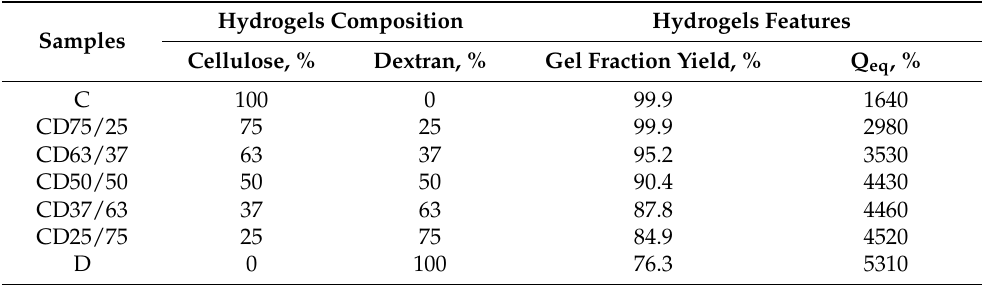
Table 1. The composition of cellulose-dextran hydrogels and their main features.